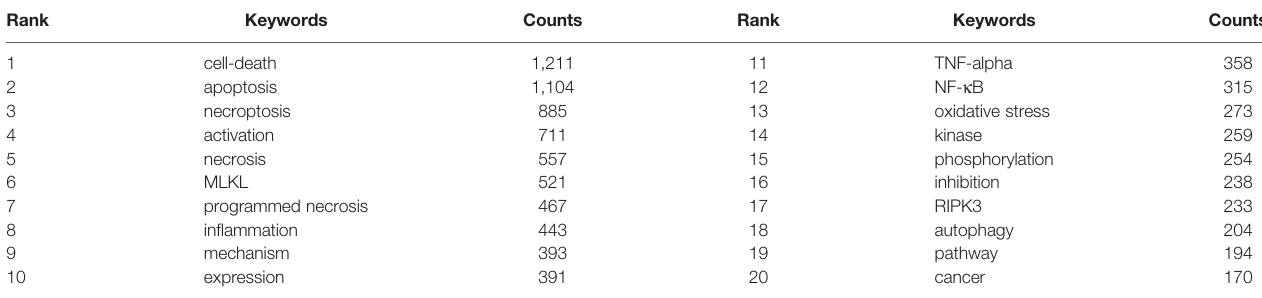
TABLE 5 | Top 20 keywords related to necroptosis.